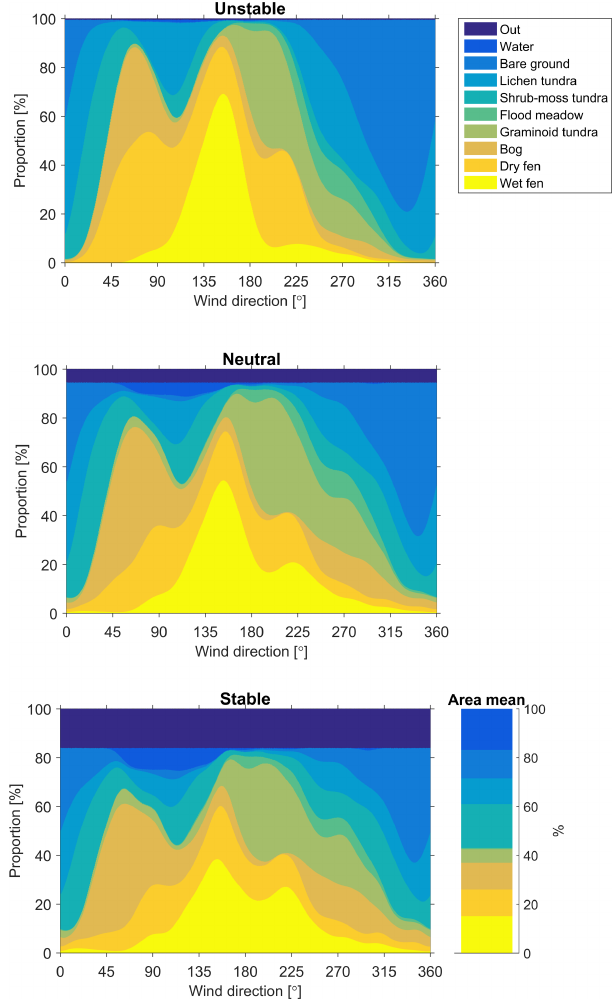
Figure 3. Proportion of different land cover classes in the flux foot- print as a function of wind direction for the three flow condition cases specified in Table 2. The rightmost panel shows the relative coverage of these classes within the study